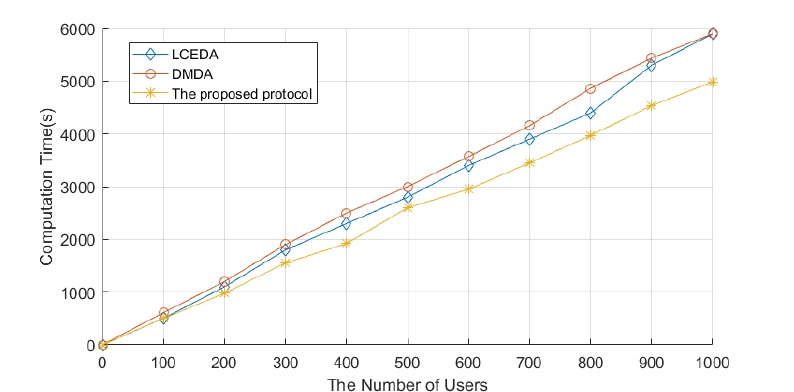
Figure 4. Computation Time of Enrollment Stage. The figure shows how the time required for LCEDA, DMDA, and the proposed scheme in the enrollment stage changes as the number of users increases. In addition, the figure reflects that the proposed scheme requires relatively little time compared to the other